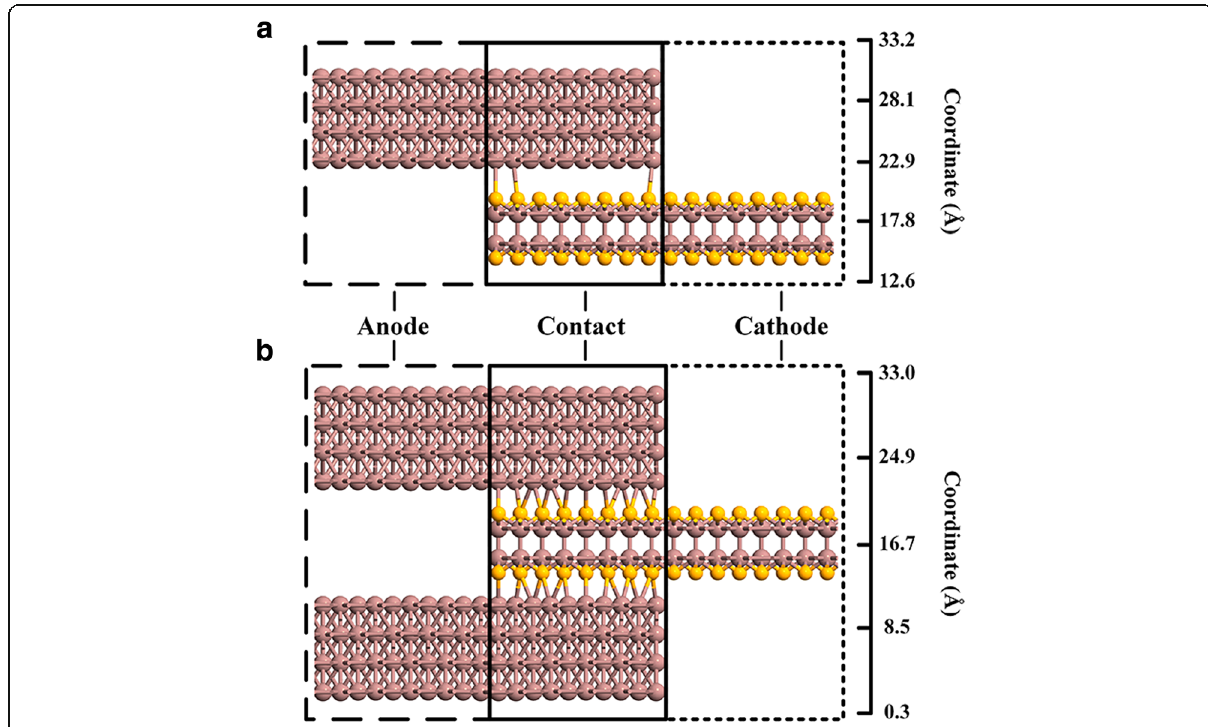
Fig. 2 Atomic structures of contact and related two-probe device used for evaluation of contact resistance. a , b are for top and sandwiched contacts, respectively